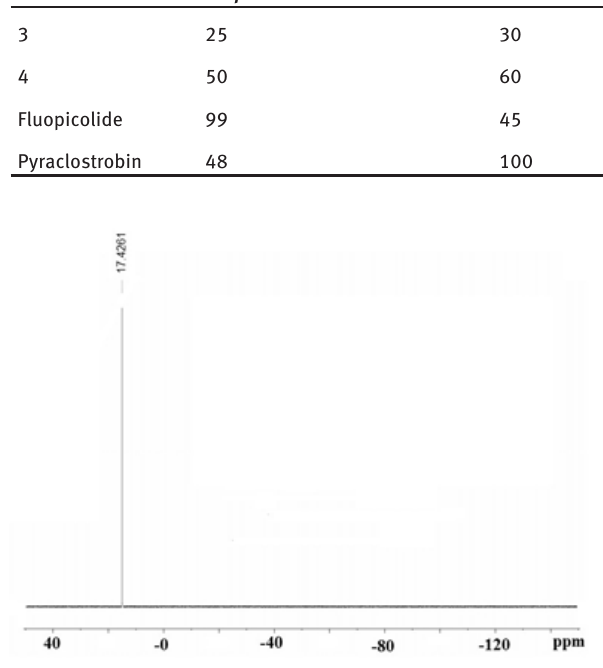
Table 1 : Fungicidal activities of steroidal derivatives 3 and 4 against four types of pathogenic fungi. Compound Pathogenic strains (Fungicidal activity (%)/50